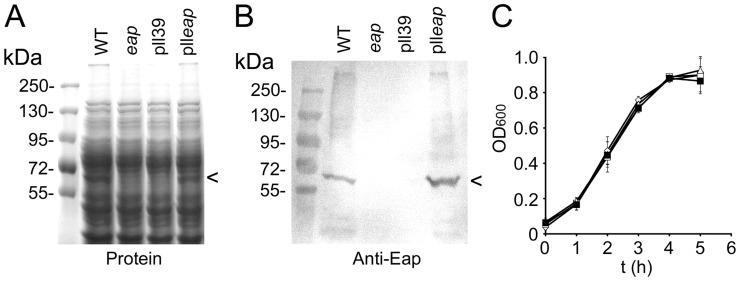
Complementation of eap deletion.
S. aureus strain Newman wild-type (WT), mAH12 (eap), mAH12pll39 (pll39) and mAH12plleap (plleap) were assessed for Eap production by SDS-PAGE (A) and Western blotting using anti-Eap antibodies (B). The position of bands corresponding to Eap is indicated (<). The growth rates of the four strains were compared to ensure that complementation did not have an adverse effect (C).